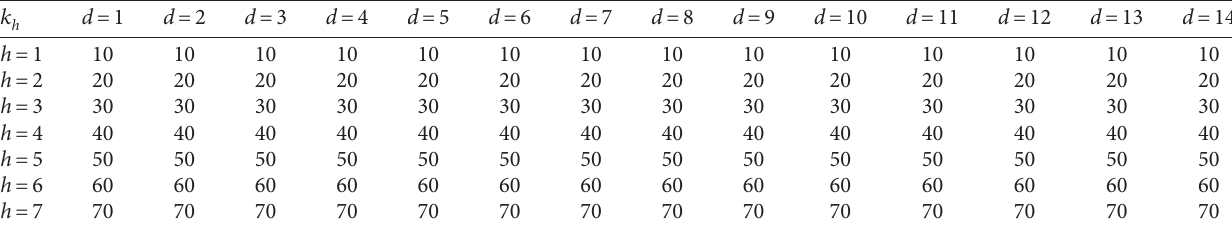
Figure 8: Schematic diagram of element discretization and stiffness modified area. Table 1: The stiffness of foundation spring calculated by equation (3).